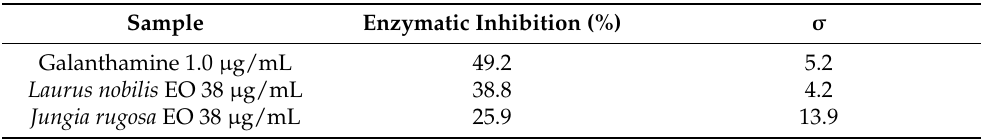
Table 2. Percent inhibition of AChE by J. rugosa EO compared to L. nobilis EO and galantamine as positive